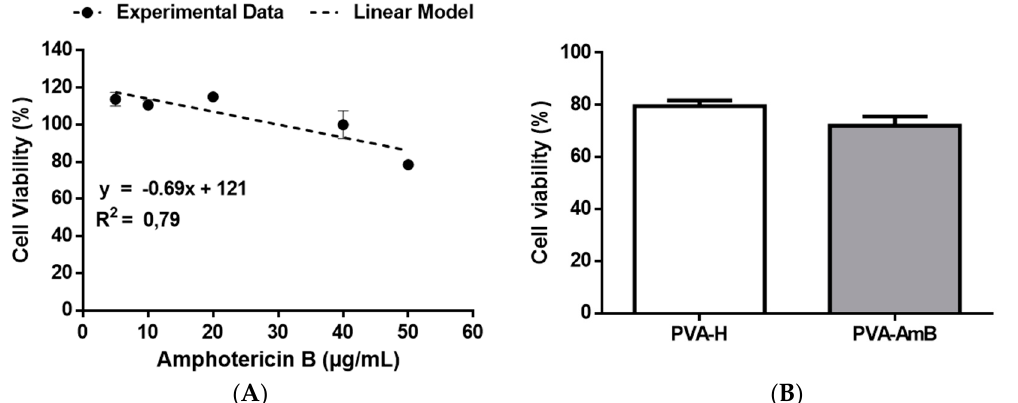
Figure 7. AmB killing curve for VERO cell lines ( A ); evaluation of the cytotoxicity of PVA-H and PVA-AmB against VERO cell lines ( B ).